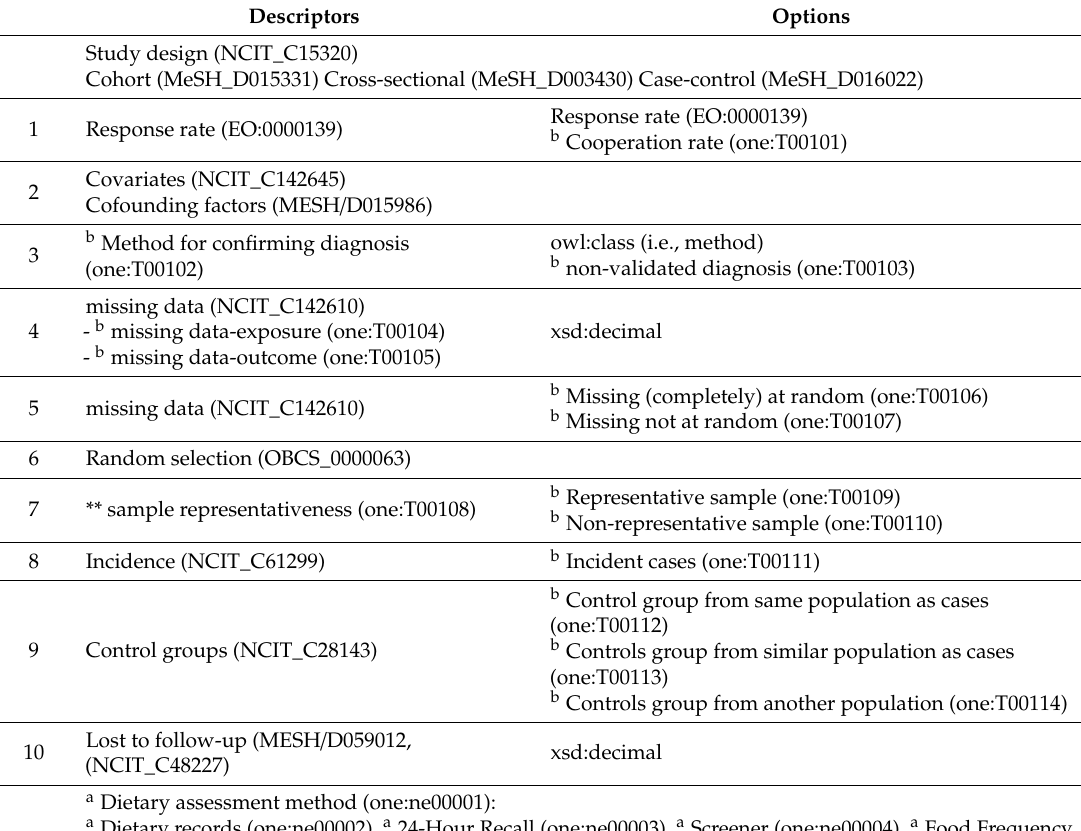
Table A9. Ontology view of data quality descriptors of observational